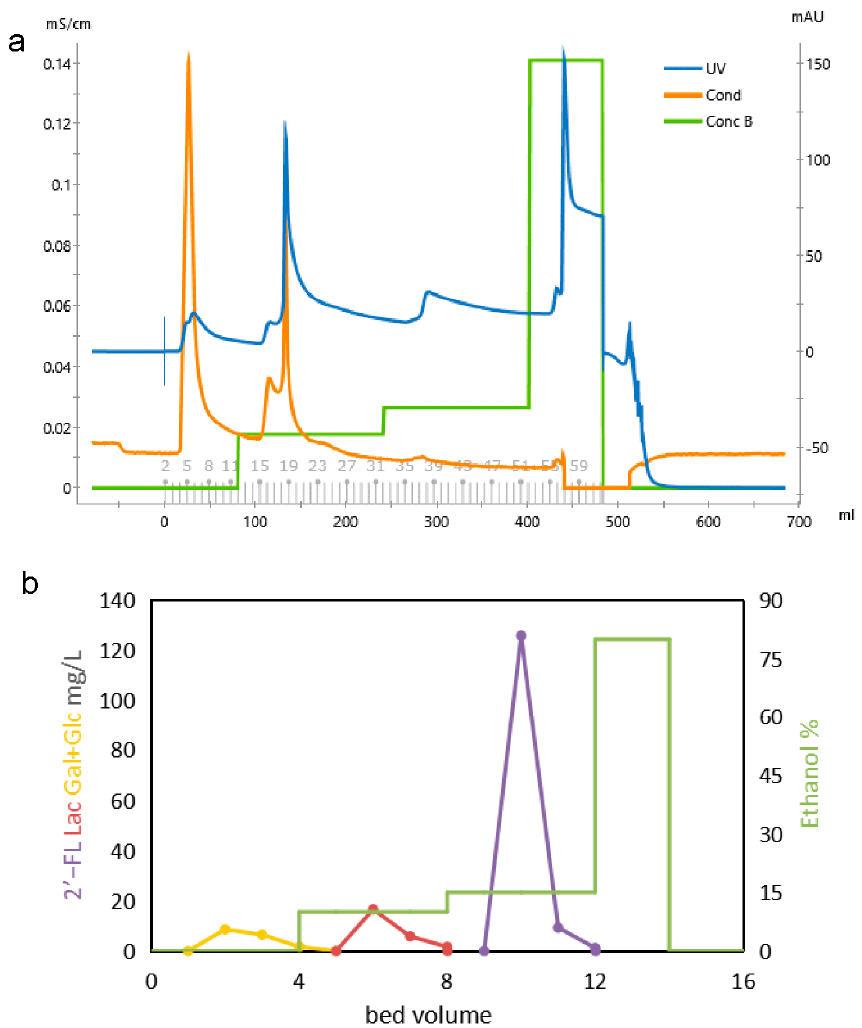
Figure 4. Results of gradient elution of activated carbon with ethanol (by green line, concentration) after optimization. ( a ) Conductivity (orange line, values on left axes in mS/cm) and UV280 absorbancy (blue line, right axes in mAU) vs. eluate volume (mL or number of sample tubes on horizontal axes); ( b ) Concentration of various sugars and ethanol concentration (green line) vs. eluate volume (number of bed volume).